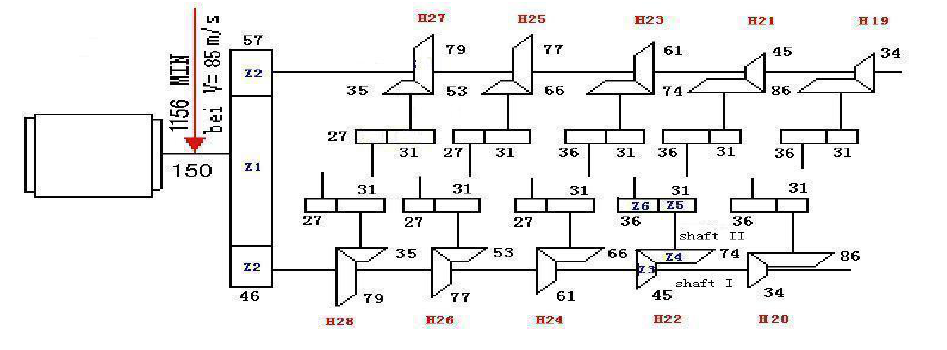
Figure 3. The gearbox transmission chain chart.